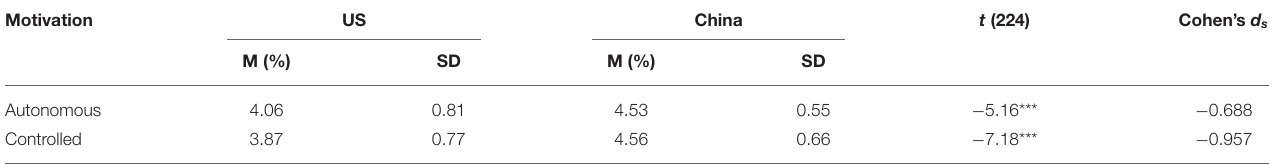
TABLE 5 | Descriptive data for motivations included in Motivation to Help Scale among Chinese and American participants. Motivation